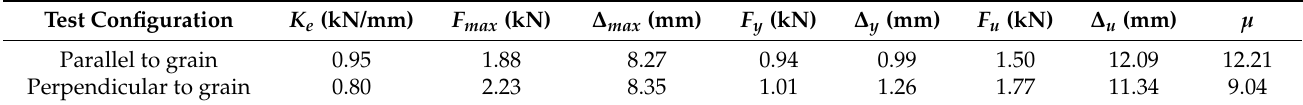
Table A1. Average response parameters of tested sheathing-to-framing